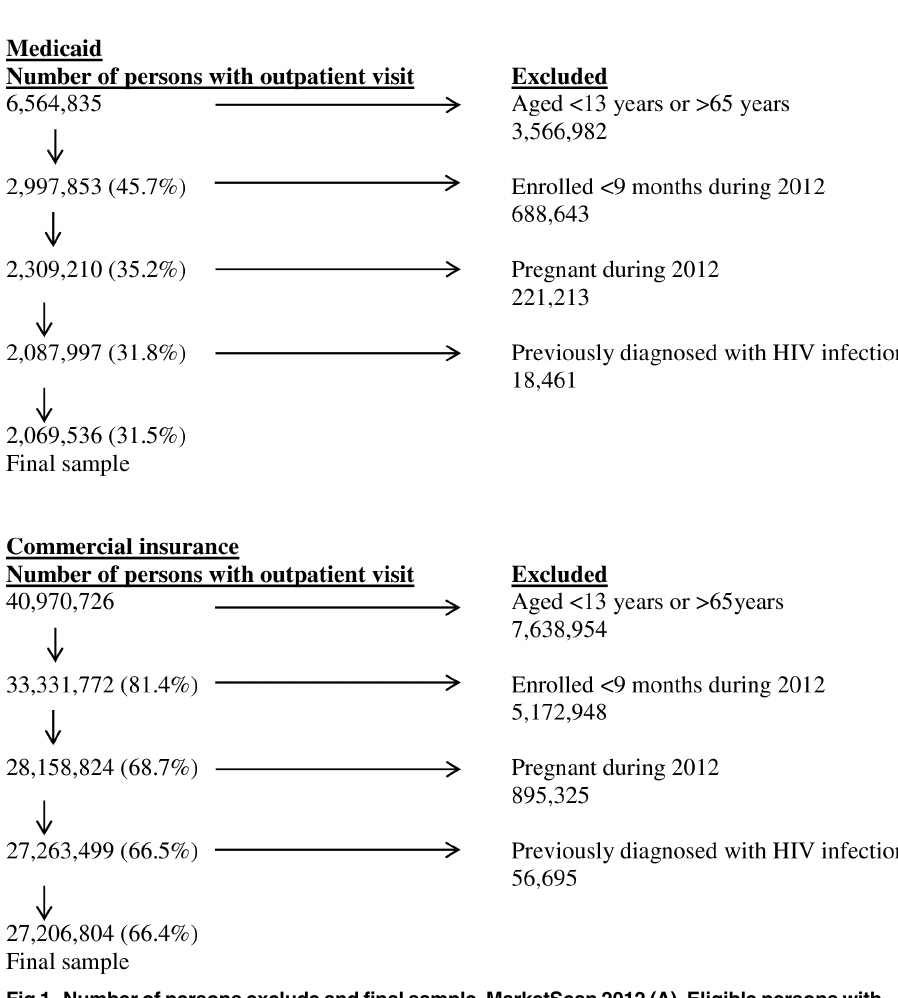
Fig 1. Number of persons exclude and final sample, MarketScan 2012 (A). Eligible persons with Medicaid. (B) Eligible patients with commercial insurance.